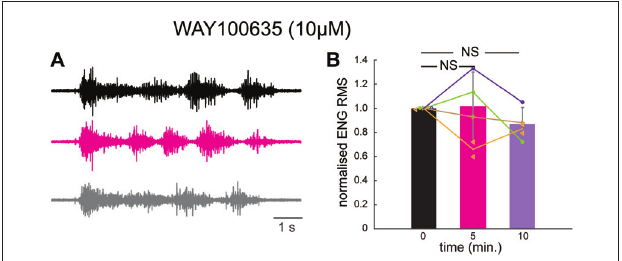
FIGURE 5 | In the presence of a 5-HT 1A receptor antagonist, stimulation of the DLF does not inhibit the scratch reflex. (A) ENG of a hip flexor nerve during scratch reflex evoked by mechanical stimulation of the skin. Upper trace (black): control reflex. Middle trace (purple): scratch reflex evoked shortly after a 1 min stimulation of the DLF at 5 Hz. Lower trace (gray): recovery recorded 5 min after 5 min after the beginning of DLF stimulation. All recordings were performed in the presence of WAY 100635 (10 µ M) perfused through the spinal column. (B) Comparison of the normalized ENG amplitude for all the preparations used for the study ( n = 4) in control conditions, after DLF stimulation and after recovery. No significant inhibition induced by